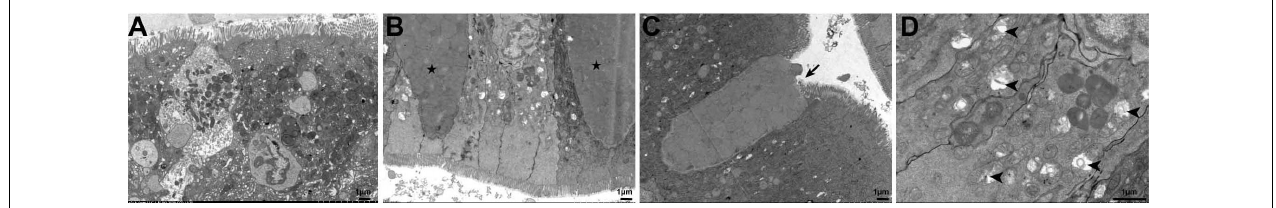
FIGURE 6 | Ultrastructural pathology of the largemouth bass intestine after 45 days of feeding the two diets. (A) The intestinal cells of largemouth bass fed the NC diet were structurally intact and undamaged; (B–D) the intestinal cells of largemouth bass fed the HC diet. Mucoprotein-filled goblet cells (pentagram), goblet cells with enlarged apical openings (arrow), mitochondria with broken cristae, vacuolated, and unidentified membranous structures (arrowhead) were observed.